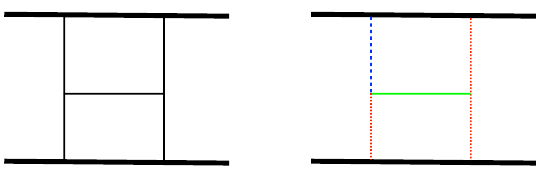
Figure 2 . On the right, one of the hundreds of possible diagrams deriving from the 3PM topology on the